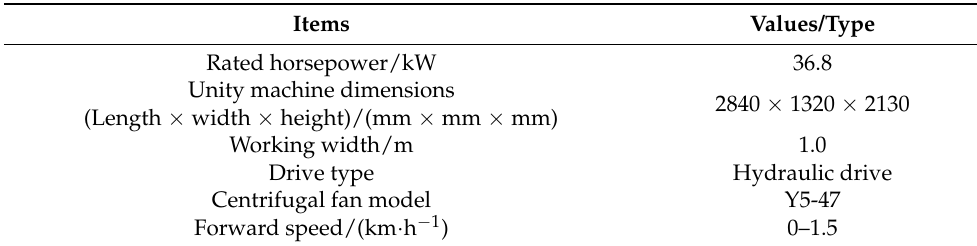
Table 1. Main technical parameters of the provoke-suction type harvester for ground jujube fruit